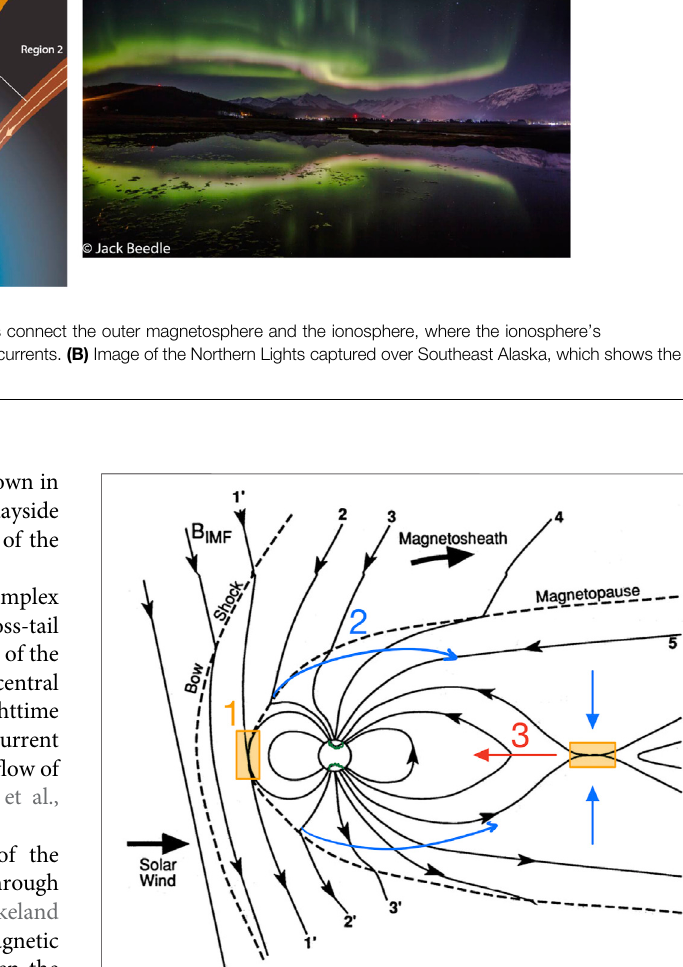
FIGURE 13 | Diagram showing the loading of energy from magnetic reconnection in the magnetopause into the magnetotail, which then causes magnetic reconnection in the tail, and unloads the stored energyinto the inner magnetosphere. As a cycle this follows the following points: (1) reconnectionoccursonthedaysidemagnetopause, (2) Fieldlinesandplasma convect across the polar cap, loading energy into the magnetotail, and (3) once enough energy is loaded into the tail, reconnection occurs, which sends plasma towards the Earth. Base fi gure from Eastwood et al. (2017), diagram edited to show main points and colored paths. This image was distributed under the https://creativecommons.org/licenses/by/4.0/legalcode Creative Commons Attribution 2.0 International